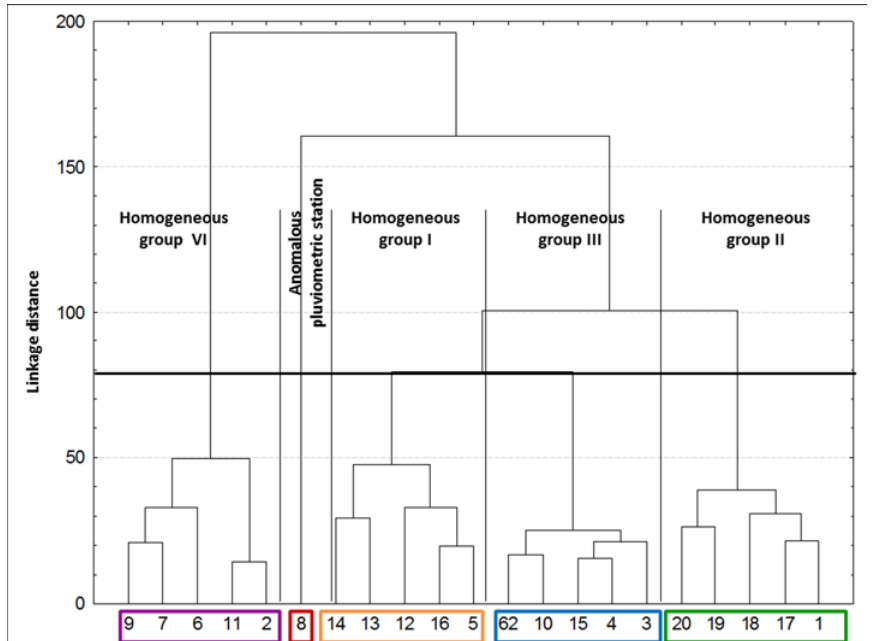
Figure 4. Dendogram with pluviometric stations and meteorological stations and their homogeneous pluviometric groups for the Alto Iguaçu watershed.